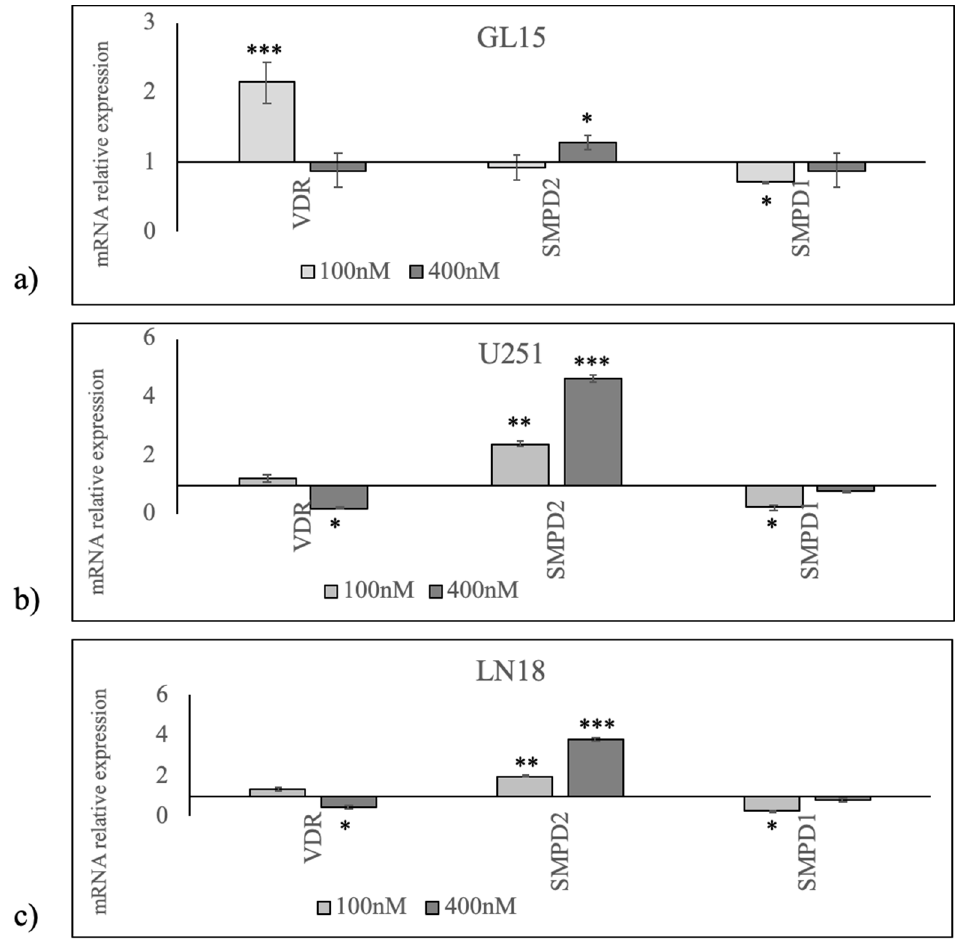
Figure 2. Effect of 100 and 400 nM 1 α ,25(OH) 2 VD 3 on vitamin D receptor (VDR), SMPD2 (encoding for neutral sphingomyelinase1), and SMPD1 (encoding for acid sphingomyelinase) gene